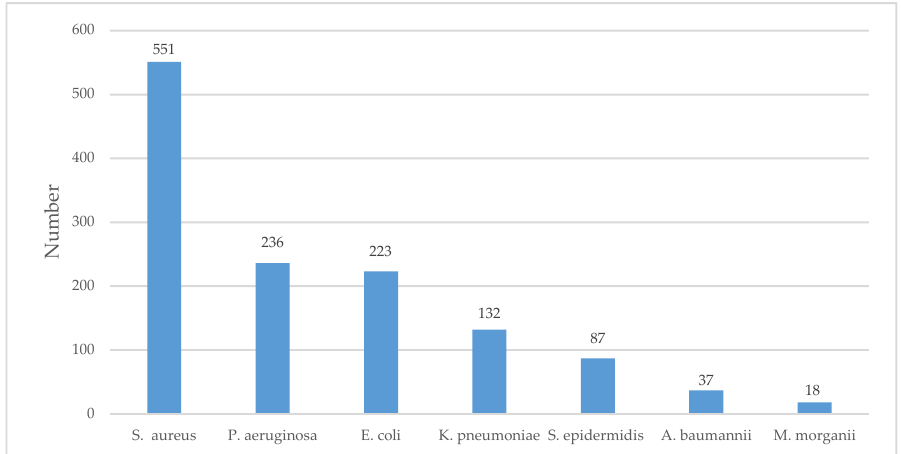
Figure 3. Commonly isolated bacterial species in DFIs using culture-based methods. The number on the bar is the sum of the total number of the isolated bacterial species in 10 studies from 2004 to 2018.